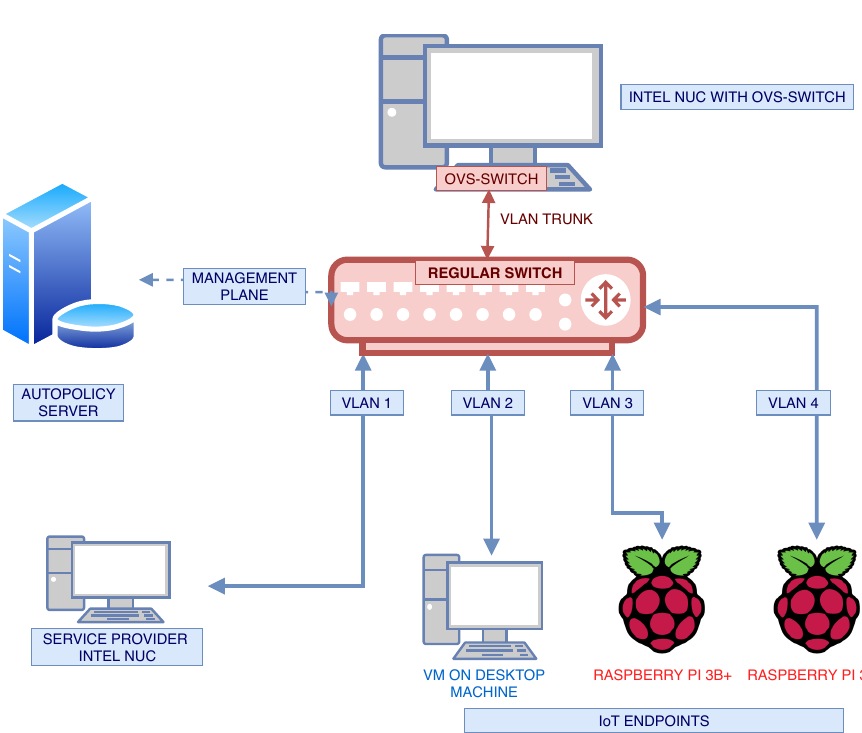
Figure 6. Logical toplogy of the experimental testbed.